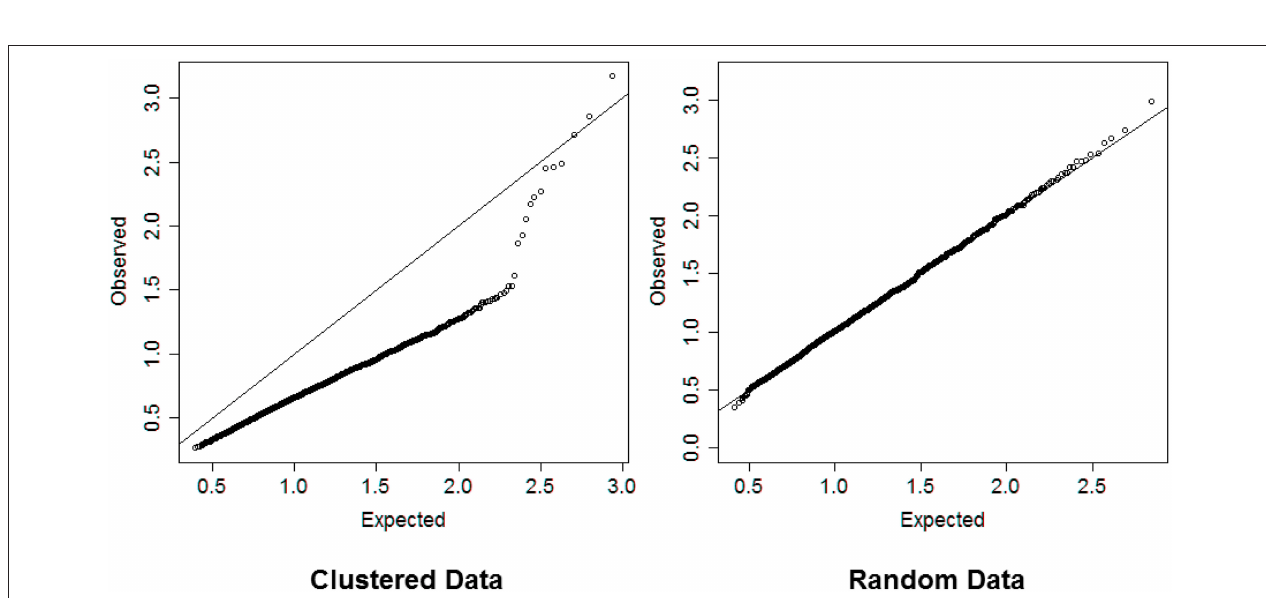
FIGURE 2 | Left panel: QQ-plot comparing expected and observed normalized distances used in hierarchical clustering of 2000 profiles of 16 variables generated from 13 clusters. Right panel: QQ-plot comparing expected and observed normalized distances used in hierarchical clustering of 2000 profiles of 16 variables generated from only one cluster. The QQ-plot is consistent with the hypothesis that when there are real clusters in the data, profiles in the same cluster should be more similar than profiles from random (unclustered) data and should produce distances that are smaller than what expected in unclusterd data, while profiles in different clusters should be more different than profiles from random data and should produce larger distances than expected by chance. Therefore, a QQ-plot with a clear S-shape as depicted in the plot on the left panel would suggest the presence of very distinct clusters in the data.